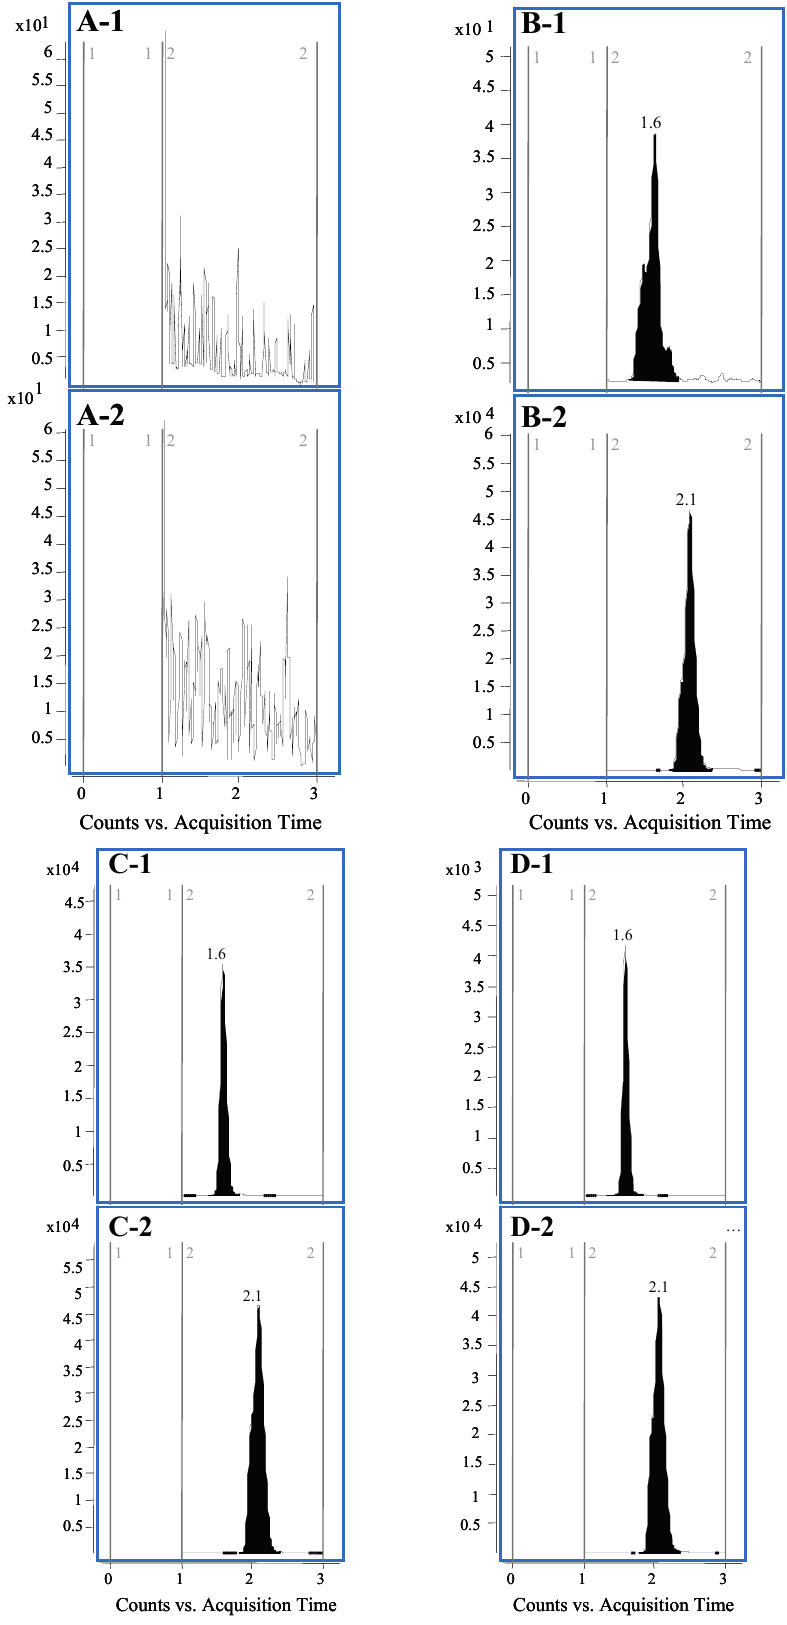
Figure 2. Typical LC-MS/MS chromatograms: ( A ) blank plasma; ( B ) blank plasma spiked with PDC (2.0 ng/mL) and IS (200 ng/mL); ( C ) rat plasma after oral administration of pure PDC; ( D ) rat plasma after oral administration of IRE. 1: PDC; 2: